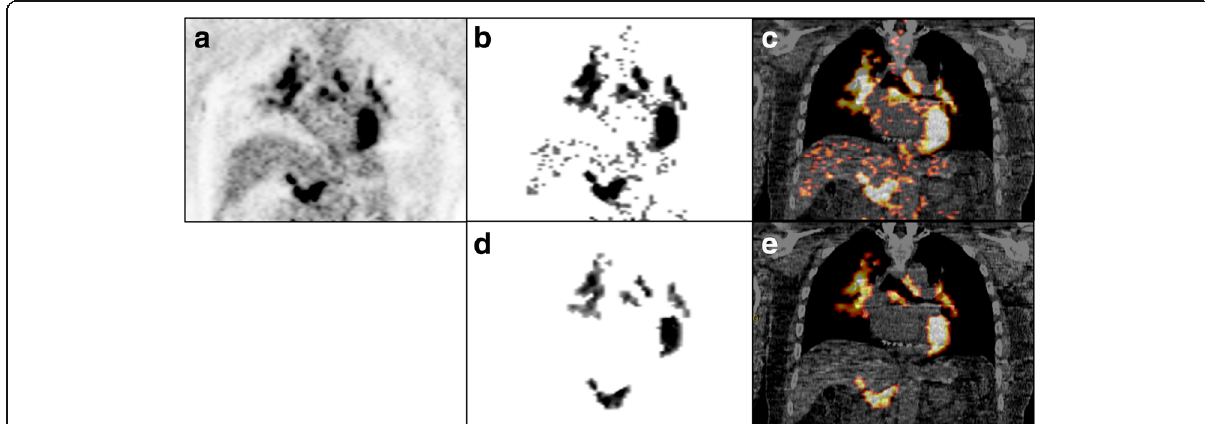
Fig. 1 Post-processing of FDG PET/CT images. Attenuation-corrected coronal PET image ( a ), post segmented PET (using a threshold of max SUV of 2.5) ( b ) and fused PET/CT ( c ) images, and post refined PET ( d ) and fused PET/CT ( e )